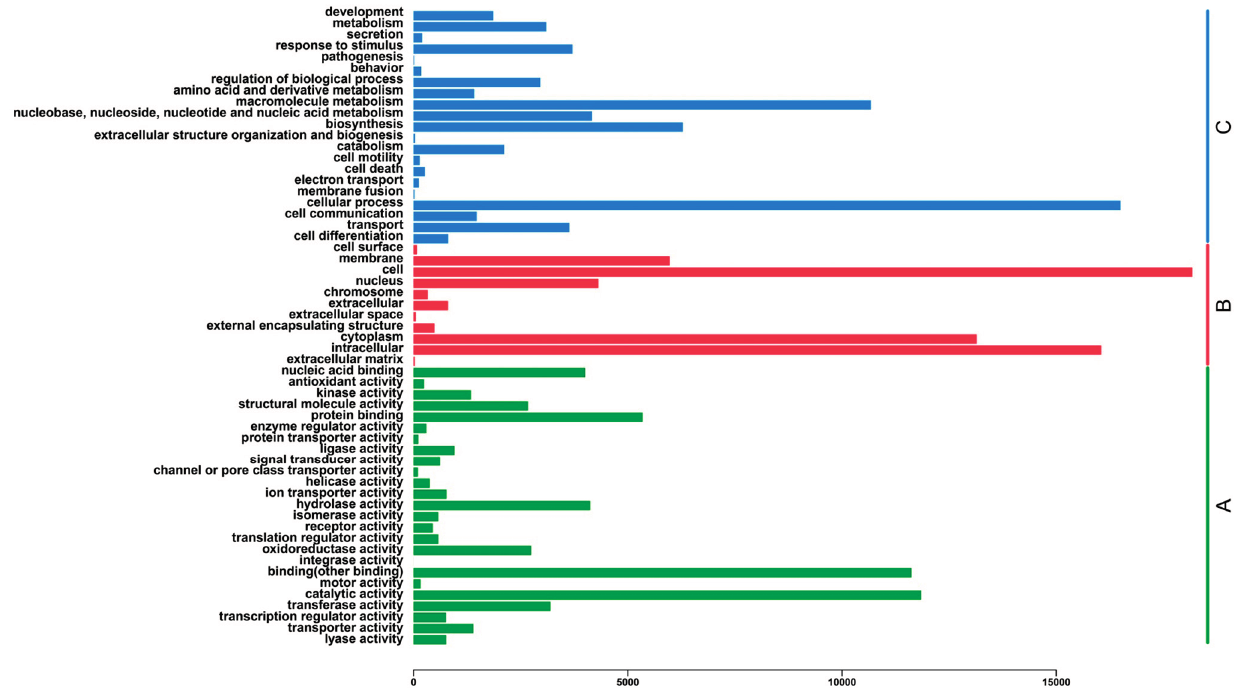
Figure 4. Histogram of Gene Ontology (GO) classifications. ( A ) Molecular function (green); ( B ) Cellular component (red); ( C ) Biological process (blue). The histogram indicates the number of unigenes that have GO annotations.